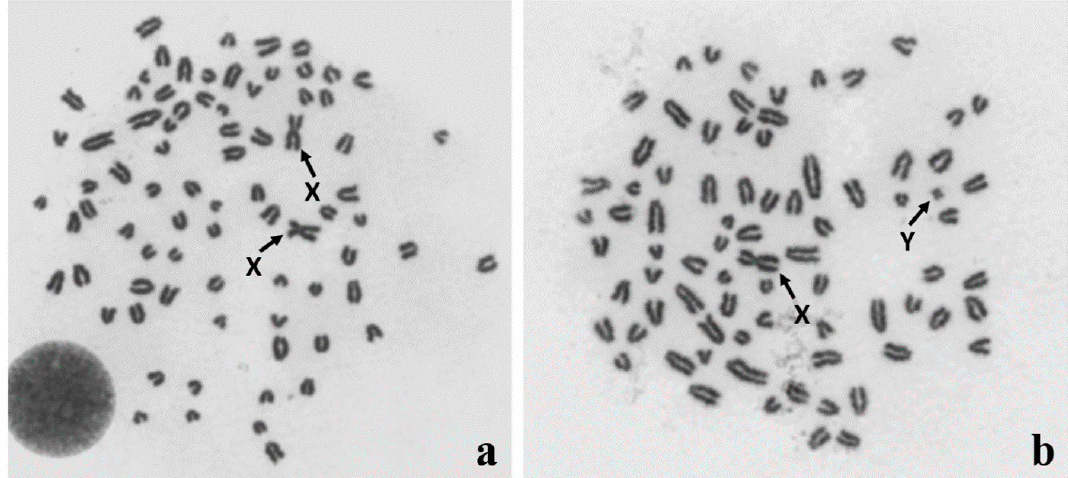
Figure 1. Identification of ( a ) 78,XX and ( b ) 78,XY Giemsa-stained metaphase spreads from in vitro cultured leukocytes obtained from a DSD (disorder of sex development) dog. Sex chromosomes are indicated with arrows.